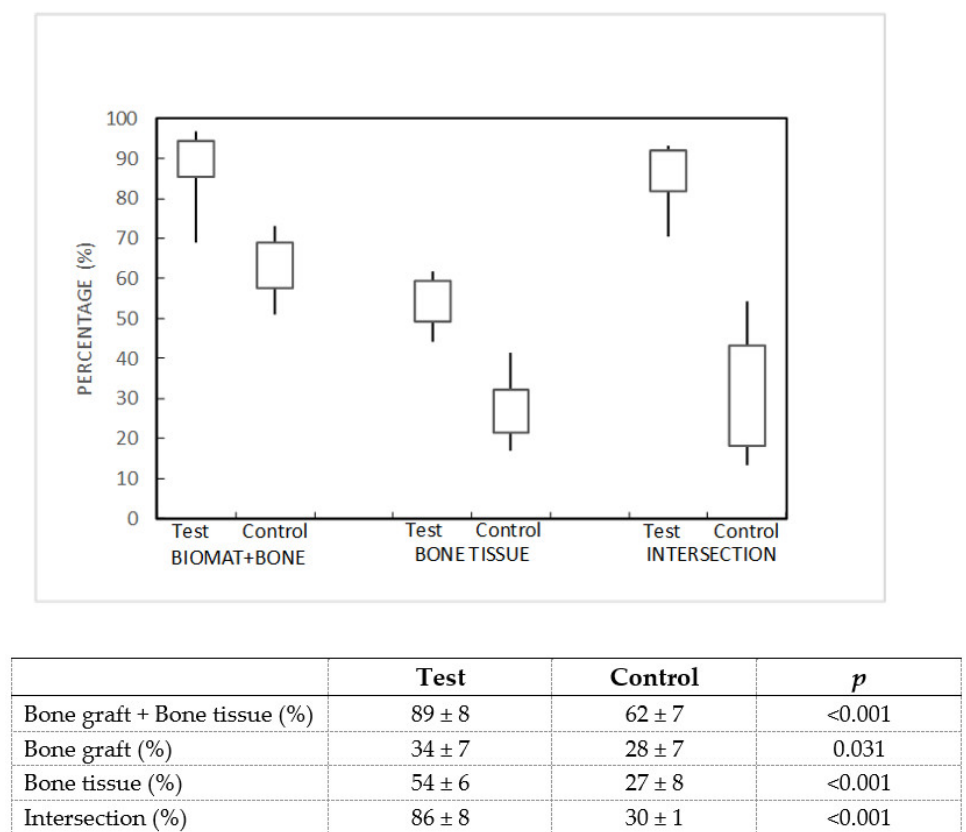
Figure 5. Boxplot and table of the microtomographic results. Percentage of the bone graft + bone tissue (BIOMAT + BONE), the bone tissue, and the intersection in percentage for the marine bone graft (test) and the Bio-Oss ® (control).